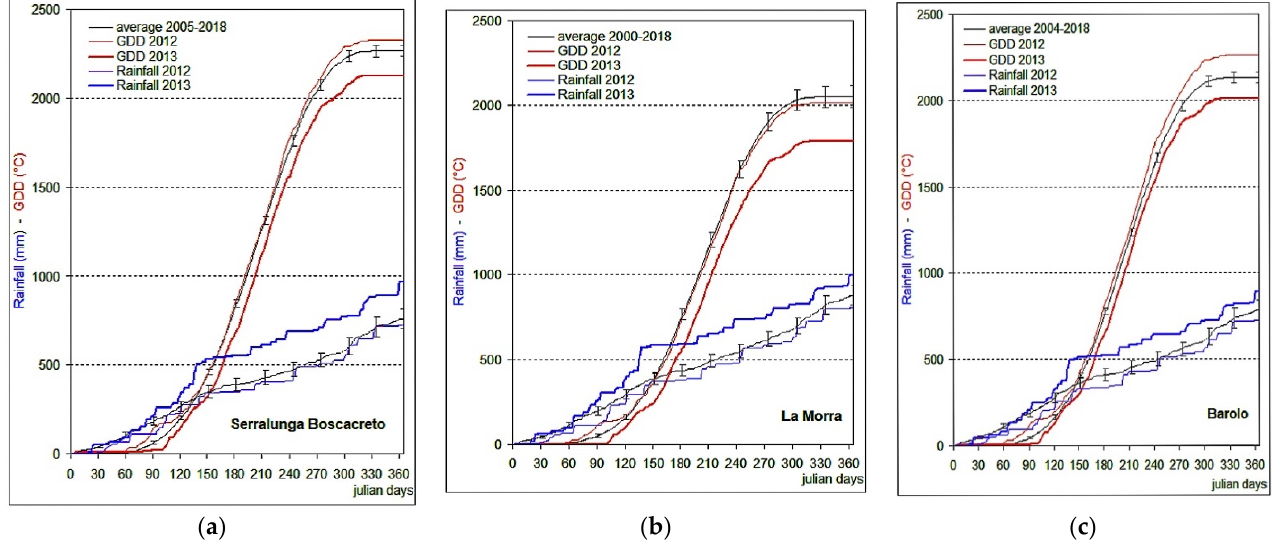
Figure 3. Yearly cumulated growing degree days (GDD, °C—red lines) and rainfall (mm, blue lines) of 2012, 2013 (bold lines), and average values of the time series of both parameters (black lines) ± standard errors, calculated for the sites used as a reference for the three mesoclimatic units in the study area. Average values were calculated for 14 years for Serralunga Boscareto (SB, a ), 19 years for La Morra (LM, b ), and 15 years for Barolo (B, c ).